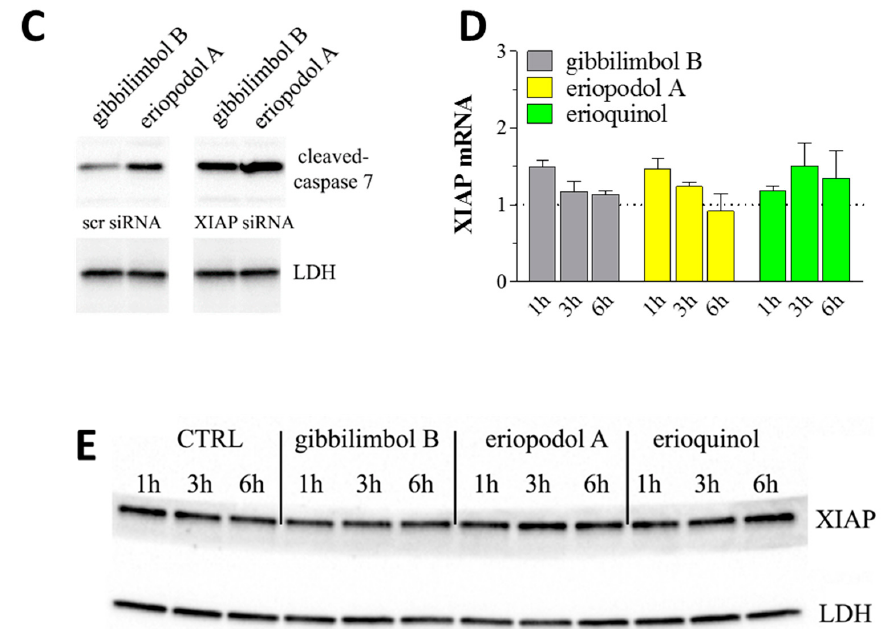
Figure 12. X-linked inhibitor of apoptosis protein (XIAP) as a molecular target of Piper genus-derived compounds. ( A ) Western blot analysis of XIAP in MCF7 cells both untransfected (CTRL, control) or transfected for 24 h with a XIAP-specific and scrambled targeting (scr) siRNA (50 nM). Lactate dehydrogenase (LDH) was used as internal standard. Low panel: densitometric analysis expressed as fold change of scr siRNA. Images and data are representative of three independent experiments. **P < 0.001 relative to scr siRNA. ( B ) MCF7 cells were transfected for 24 h with a XIAP-specific or scr siRNA (50 nM) and then cultured in the absence (CTRL) and in the presence of 30 µ g / mL gibbilimbol B / eriopodol A or 10 µ g / mL erioquinol for 6 h, before 3-(4,5-dimethylthiazol-2-yl)-2,5-diphenyltetrazolium bromide (MTT) assay. Results are expressed by setting the absorbance of the reduced MTT in the scr siRNA CTRL, as 100%. Data are representative of three independent experiments. * p < 0.0001 relative to the respective scr siRNA. ( C ) Western blot analysis of cleaved-caspase 7 in MCF7 cells transfected for 24 h with a XIAP-specific or scr siRNA (50 nM) and then cultured in the presence of 30 µ g / mL gibbilimbol B and eriopodol A for 6 h. LDH was used as internal standard. Images are representative of three independent experiments. ( D ) Real-time PCR and ( E ) Western blot analysis of XIAP mRNA and protein expression, respectively, in MCF7 cells treated for increasing times in the absence (CTRL) and in the presence of 30 µ g / mL gibbilimbol B / eriopodol A or 10 µ g / mL erioquinol. β -actin (PCR) and LDH (Western blot) were used as internal standards. PCR results are expressed as fold change of respective CTRL, set as 1. Images and data are representative of three independent